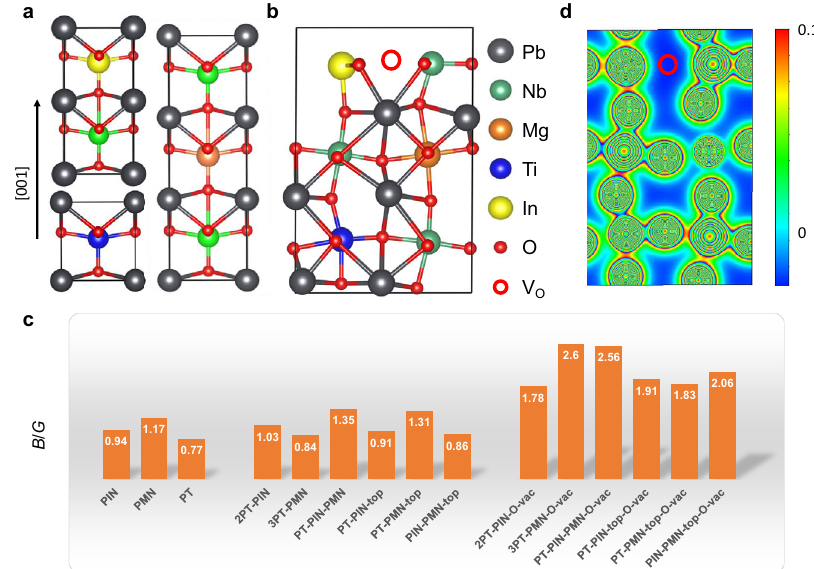
Fig. 3 First principles atomistic investigation for the plasticity in PIN-PMN-PT. a Three sub-unit cells for Pb(In 1/2 Nb 1/2 )O 3 (PIN), Pb(Mg 1/3 Nb 2/3 )O 3 (PMN) and PbTiO 3 (PT). b An example of relaxed atomic structure containing interfaces formed by one PIN, one PMN and one PT with one oxygen vacancy ( V O ) at the interface of PIN and PMN. c Calculated bulk modulus/shear modulus ( B / G ) ratios for various bulk, pristine interfaces, and interfaces with V O . Higher B / G ratios (>1.75) suggest ductile behaviour in PIN-PMN-PT. d Calculated valence charge density 2D contour plot (colours assigned recursively) on the (020) plane of the structure shown in b . The strength of covalent bonding is indicated by the colour bar. The presence of V O eliminates the local covalent